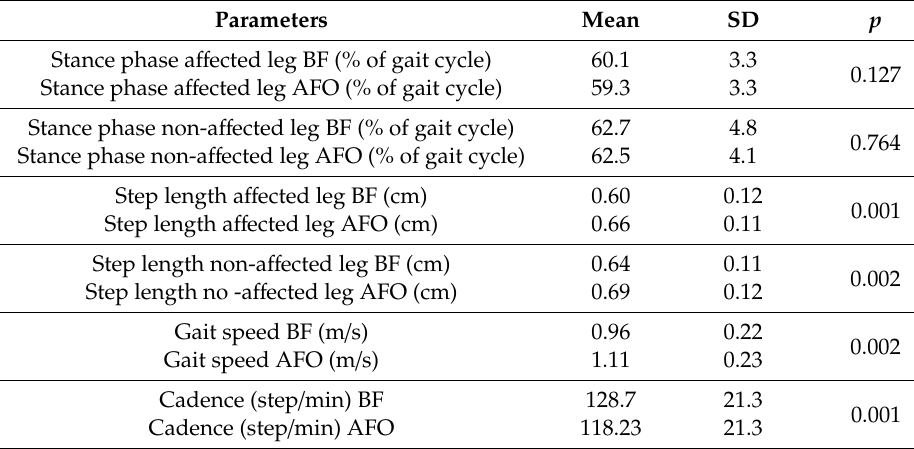
Table 2. Spatio-temporal gait